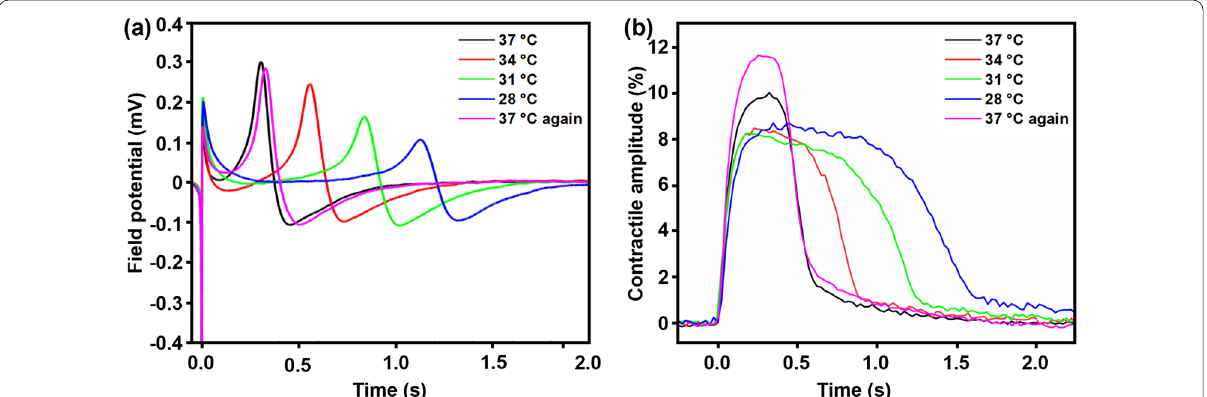
Fig. 4 a Overlapped curves of field potential at different temperatures from 37 to 28 °C, b overlapped curves of contractility at different temperatures from 37 to 28